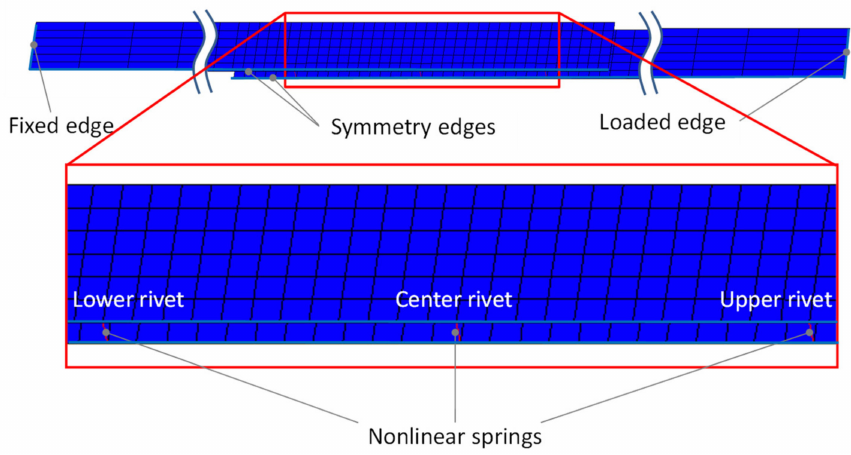
Figure 15. Simplified model of triple-row joint for the finite element